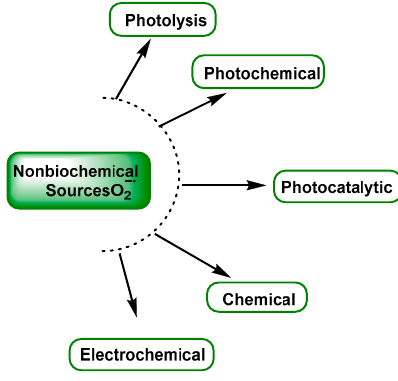
Figure 17. Non-Biochemical sources of superoxide [25].